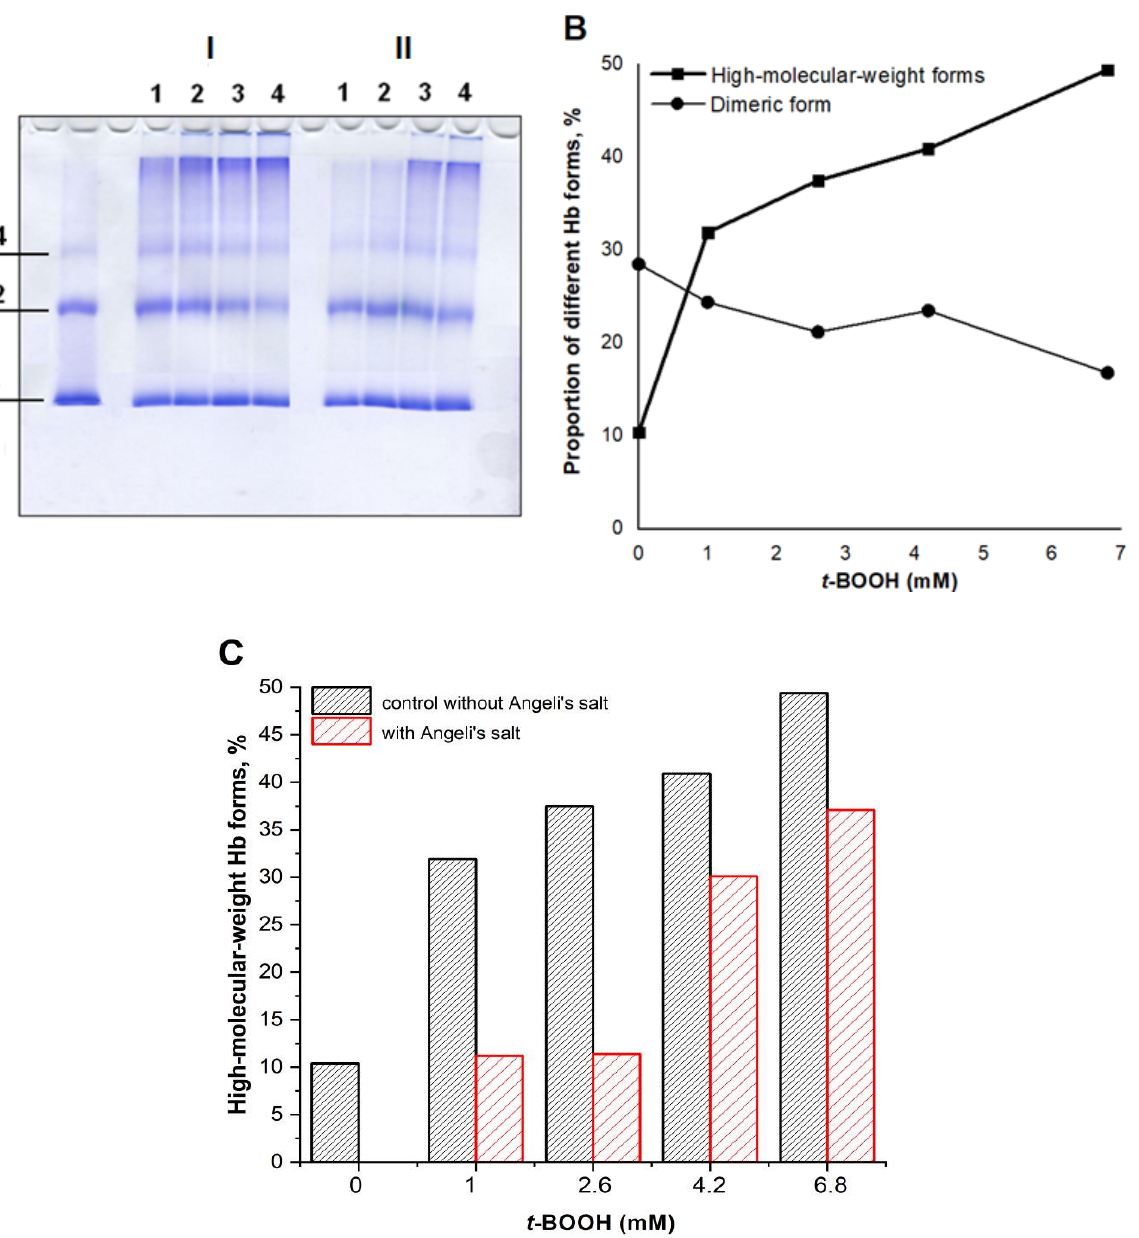
Figure 5. Effect of Angeli’s salt on heme group destruction ( A ) and formation of carbonyl groups on metHb ‐ H 2 O; ( B ) under the influence of various t ‐ BOOH concentrations. Control, without An ‐ geli’s salt (1), with Angeli’s salt (2). Reaction mixture: 0.15 mM metHb ‐ H 2 O in 100 mM PBS (pH 7.4), 2 mM Angeli’s salt. Results are depicted as the mean with S.E.M. of three independent experiments ( n = 3). Student t ‐ test ( А ) ( p ≤ 0.05), student t ‐ test ( В ) ( p ≤ 0.05 for all point except 4.25 mM t ‐ BOOH, for this point, non ‐ significant).